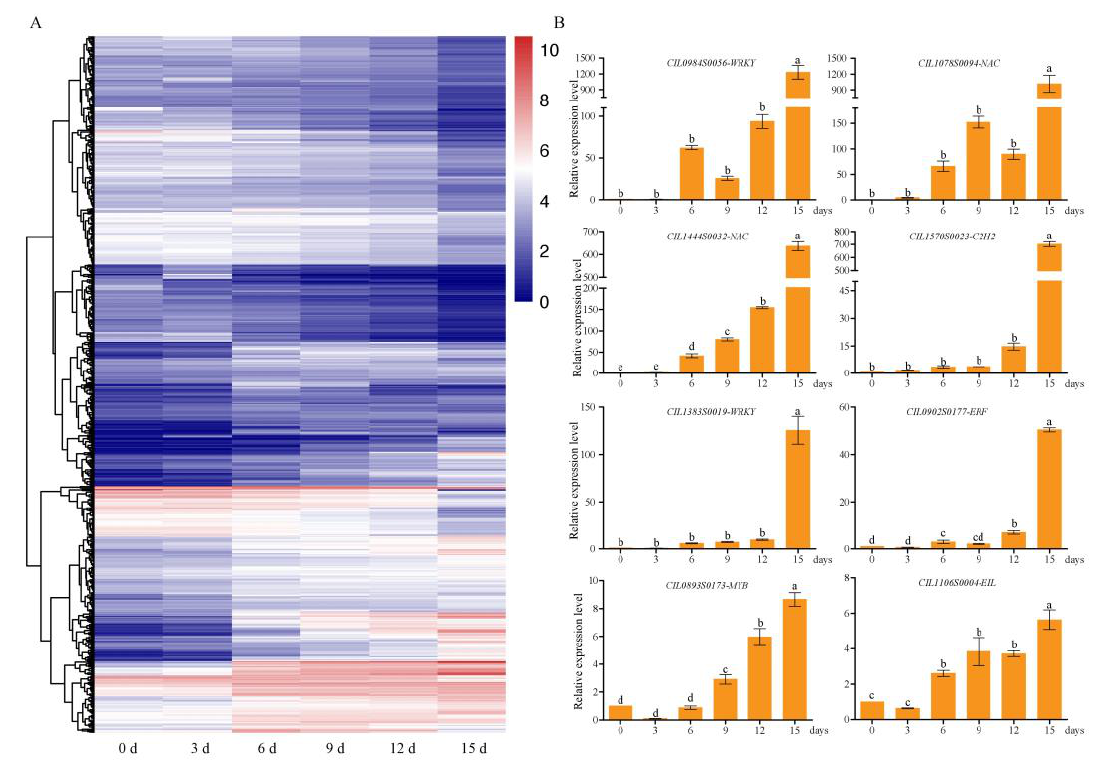
Figure 6. Expression analysis of differentially expressed TF genes under drought stress. ( A ) The heatmap for the clustering analyses of differentially expressed TFs was built based on log 2 (FPKM+1) values, with the bar indicating the scale of gene expression levels. ( B ) Validation of the selected TF genes in pecans using the qRT-PCR approach. The actin gene was selected as the internal control. Letters represented significant differences according to Duncan’s test ( p < 0.05). Error bars indicated the means ± SEs obtained from three biological replicates.